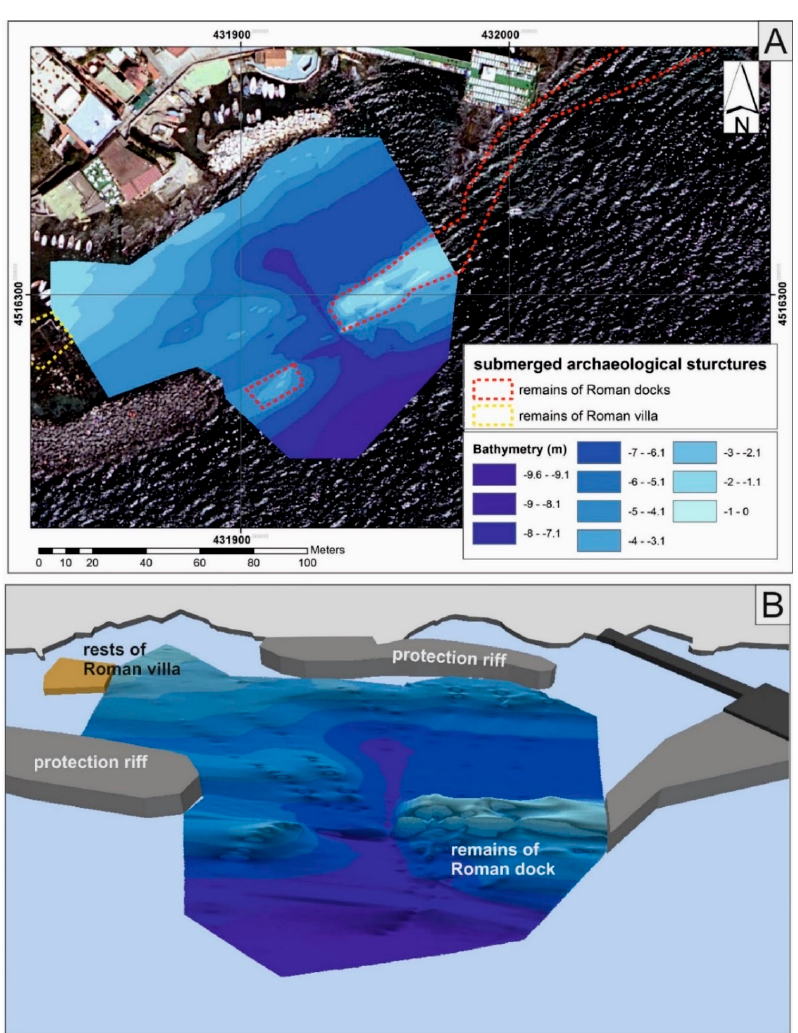
Figure 16. ( a ) 2D visualization of the sea floor digital model of the study area—Marechiaro harbour